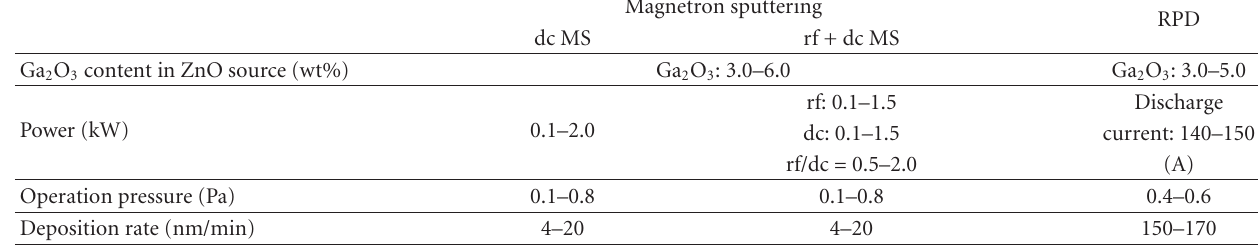
Table 1: Specifications for the formation of GZO films by dc MS, rf + dc MS, and RPD.